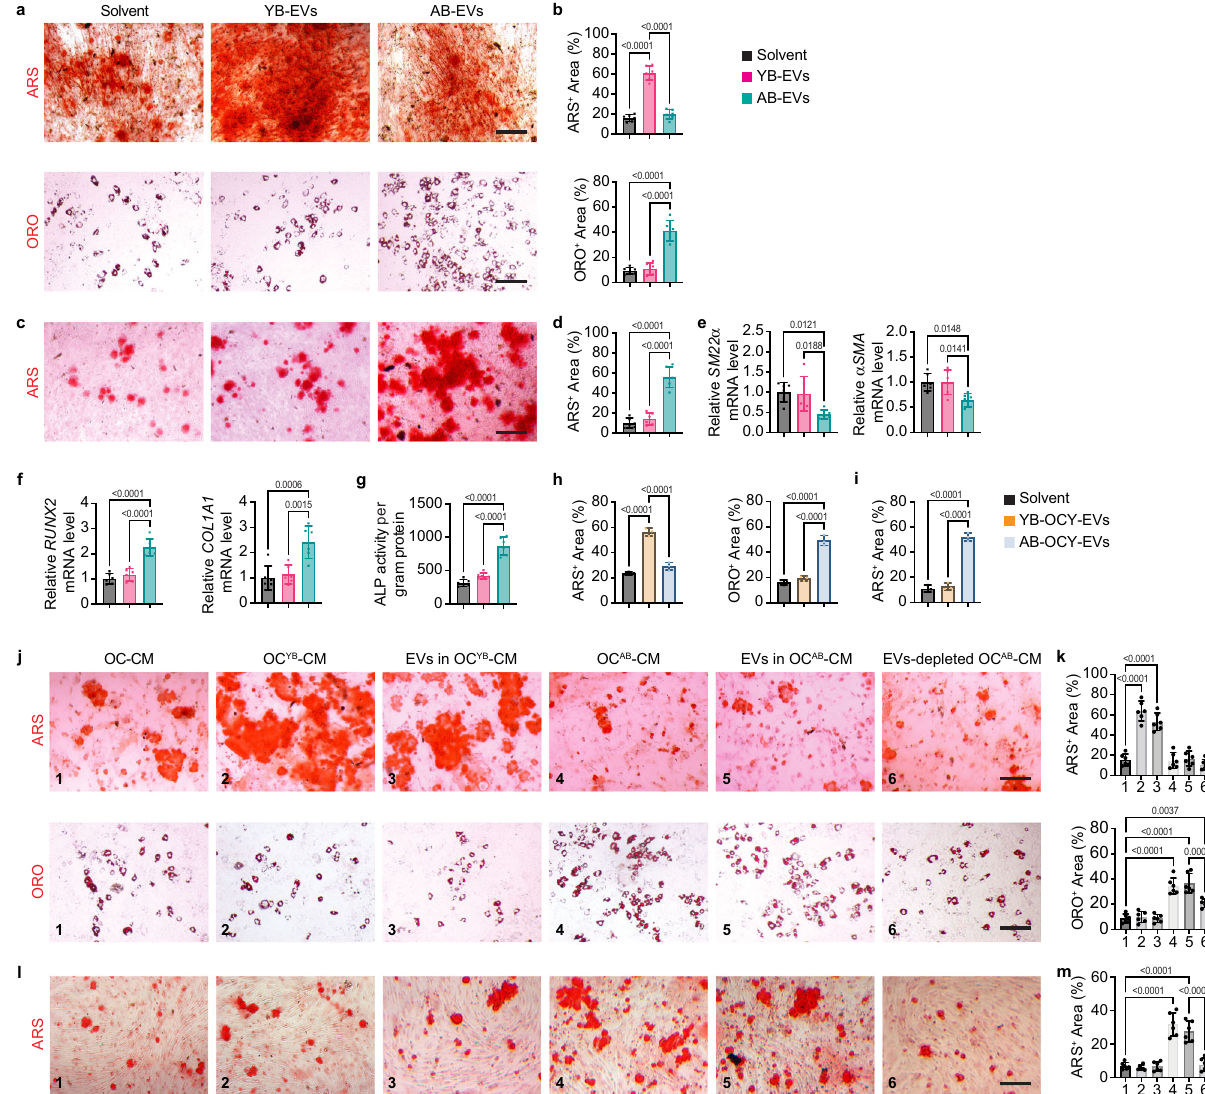
Fig. 2 AB-EVs favor adipogenesis rather than osteogenesis of BMSCs and augment osteogenic transdifferentiation of VSMCs. a,b , ARS or ORO staining of BMSCs treated with solvent, YB-EVs, or AB-EVs under osteogenic or adipogenic induction ( a ) and quanti fi cation of the percentages of ARS + (red) and ORO + (red) areas ( b ). Scale bar: 50 μ m. n = 6 biologically independent cells per group. c – g , ARS staining ( c ), quanti fi cation of the percentage of ARS + areas (red; d ), qRT-PCR analysis of SM22 α and α SMA ( e ), RUNX2 and COL1A1 ( f ) expression, and ALP activity ( g ) in VSMCs treated with solvent, YB-EVs, or AB-EVs under osteogenic induction. Scale bar: 50 μ m. n = 6 biologically independent cells per group. h Quanti fi cation of the percentages of ARS + and ORO + areas in BMSCs treated with solvent, YB-OCY-EVs, or AB-OCY-EVs under osteogenic or adipogenic induction. n = 3 biologically independent cells per group. i Quanti fi cation of the percentages of ARS + areas in VSMCs treated with solvent, YB-OCY-EVs, or AB-OCY-EVs under osteogenic induction. n = 3 biologically independent cells per group. j – k , ARS and ORO staining ( j ) and quanti fi cation of the percentages of ARS + (red) and ORO + (red) areas ( k ) in BMSCs with different treatments under osteogenic or adipogenic induction. OC: osteoclasts; CM: conditioned media. Scale bar: 50 μ m. n = 6 biologically independent cells per group. l – m , ARS staining ( l ) and quanti fi cation of the percentage of ARS + areas (red; m ) in VSMCs with different treatments under osteogenic induction. Scale bar: 50 μ m. n = 6 biologically independent per group. Experiments in a – d and h – m were repeated independently three times with similar results. The illustrated results represented one of the three independent experiments. Experiments in e – g were performed with six biological replicates per group without independent repetition. Data were presented as mean ± SD. Statistical signi fi cance was determined by one-way ANOVA with Bonferroni post hoc test. Source data are provided as a Source Data fi le. stimulated adipogenesis rather than osteogenesis of BMSCs and bone mass phenotypes compared with the other two age-matched increased VSMC mineralization, while YB-EVs from rats mark- groups, as revealed by the microcomputed tomography ( μ CT)- edly enhanced calcium nodule formation of BMSCs and had no reconstructed images of femurs, the much lower trabecular bone distinct effect on BMSC adipogenesis and VSMC calci fi cation, as volume fraction (Tb. BV/TV), trabecular number (Tb. N), or/and indicated by ARS and ORO staining of the differentiated BMSCs trabecular thickness (Tb. Th), as well as the higher trabecular (Supplementary Fig. 3c, d) and ARS staining of the differentiated separation (Tb. Sp). In contrast, YB-EVs remarkably enhanced VSMCs (Supplementary Fig. 3e, f). As shown in Fig. 3b, c, the Tb. BV/TV and Tb. Th in young mice, and markedly increased AB-EVs-treated young and aged mice had the lowest trabecular Tb. Th and decreased Tb. Sp in aged mice (Fig. 3b, c). Both YB- NATURE COMMUNICATIONS| (2022) 13:1453